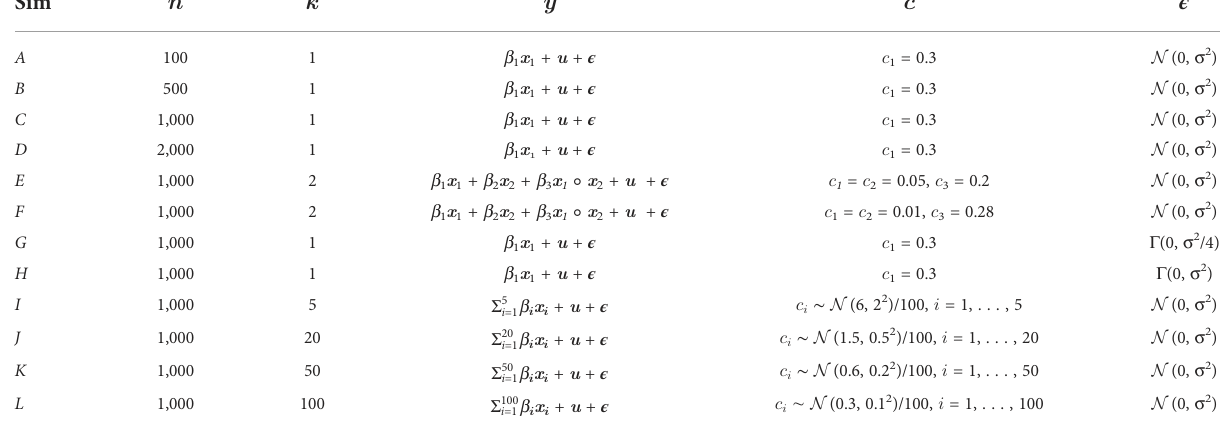
TABLE 1 Overview of simulation settings to create synthetic phenotypes for real Arabidopsis thaliana genotypes.